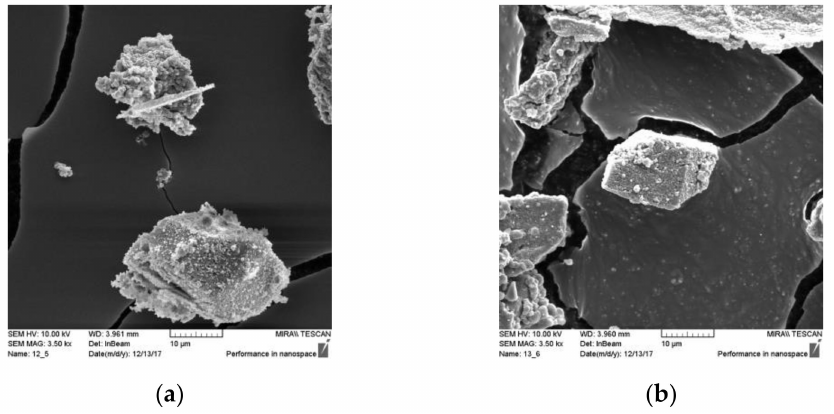
Figure 6. Micrographs of ( a ) WBA1 sample; ( b ) WBA2 sample (scanning electron microscopy magnification, SEM_MAG = 3500 ×